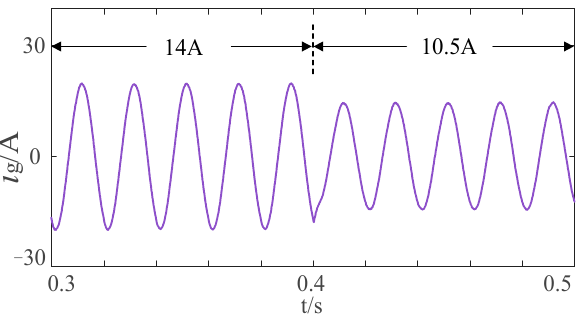
Figure 14. Dynamic response of ig of phase C.